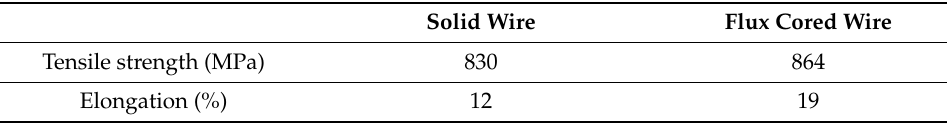
Table 1. Mechanical properties of solid and flux cored wire.